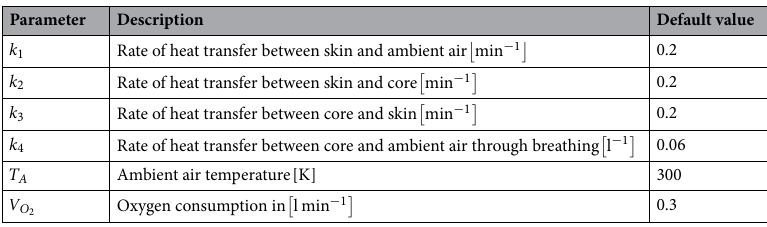
Table 2. Parameters for model (1), (2).